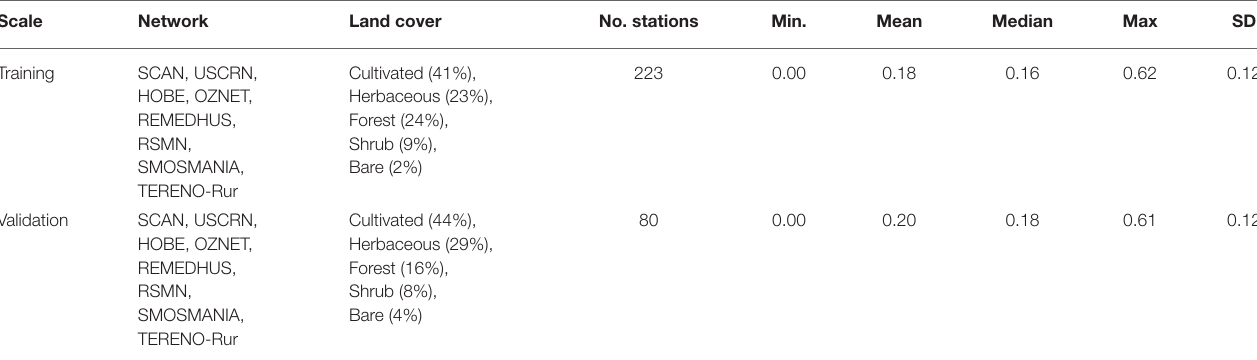
Both training and validaiton datasets consist of continental- (SCAN, USCRN) and regional- (HOBE, OZNET, REMEDHUS, RSMN, SMOSMANIA, TERENO-Rur) scale soil moisture monitoring